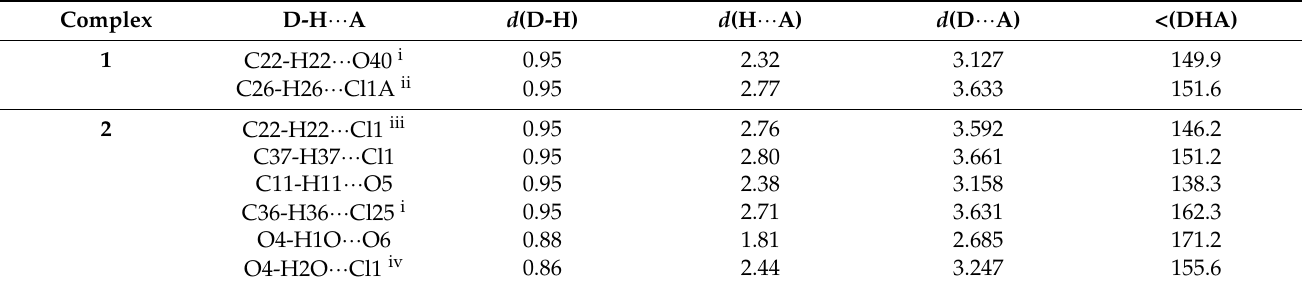
Table 3. Hydrogen bond interactions (Å, ◦ ) in 1 and 2